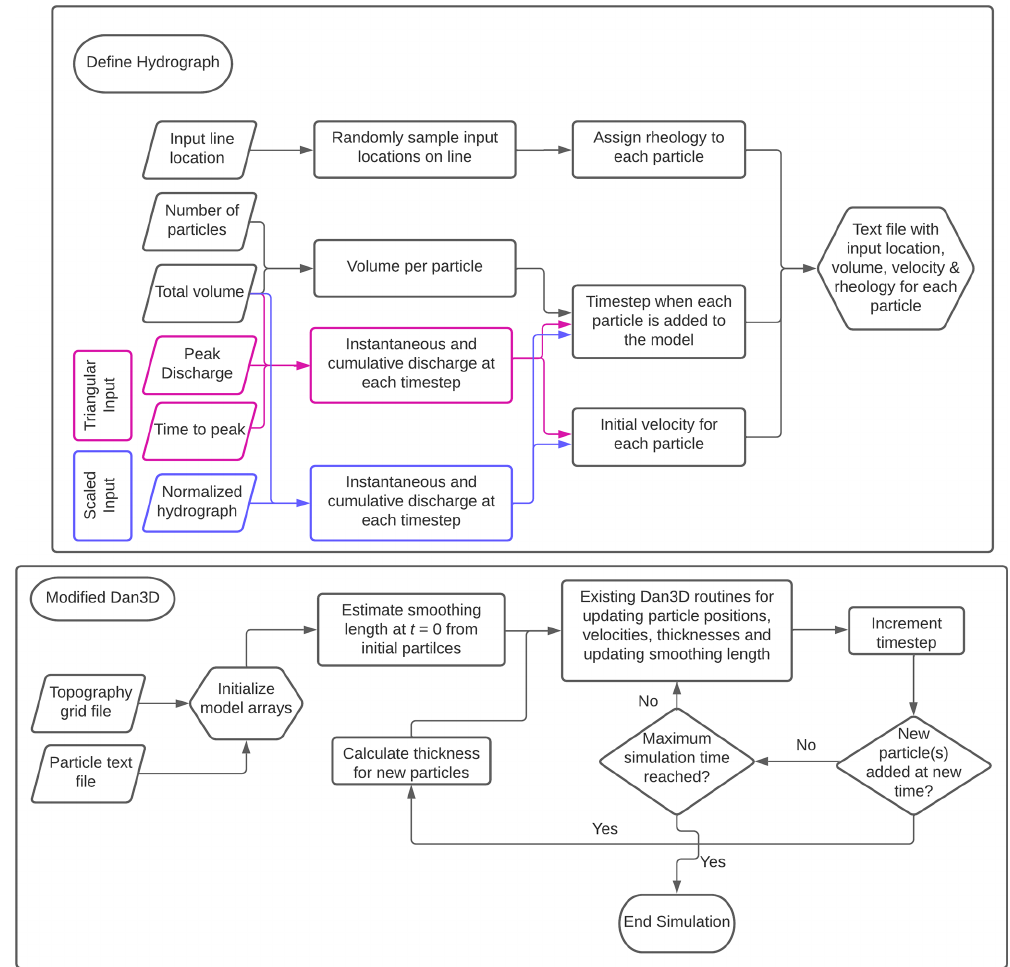
Figure 3. Workflow for Dan3D with a hydrograph input. The magenta outlines indicate steps specific to a triangular hydrograph input, while the blue outlines indicate steps specific to a scaled, real hydrograph